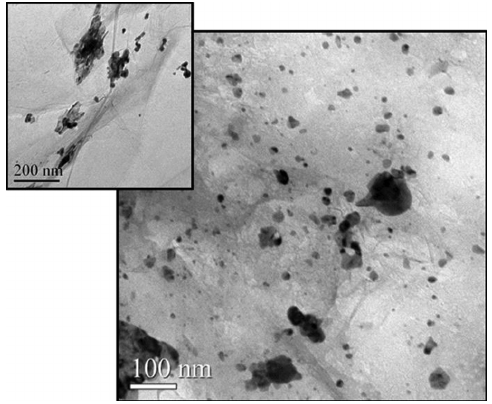
Figure 1: TEM images of Pd/G catalyst produced using a continuous microwave reactor.